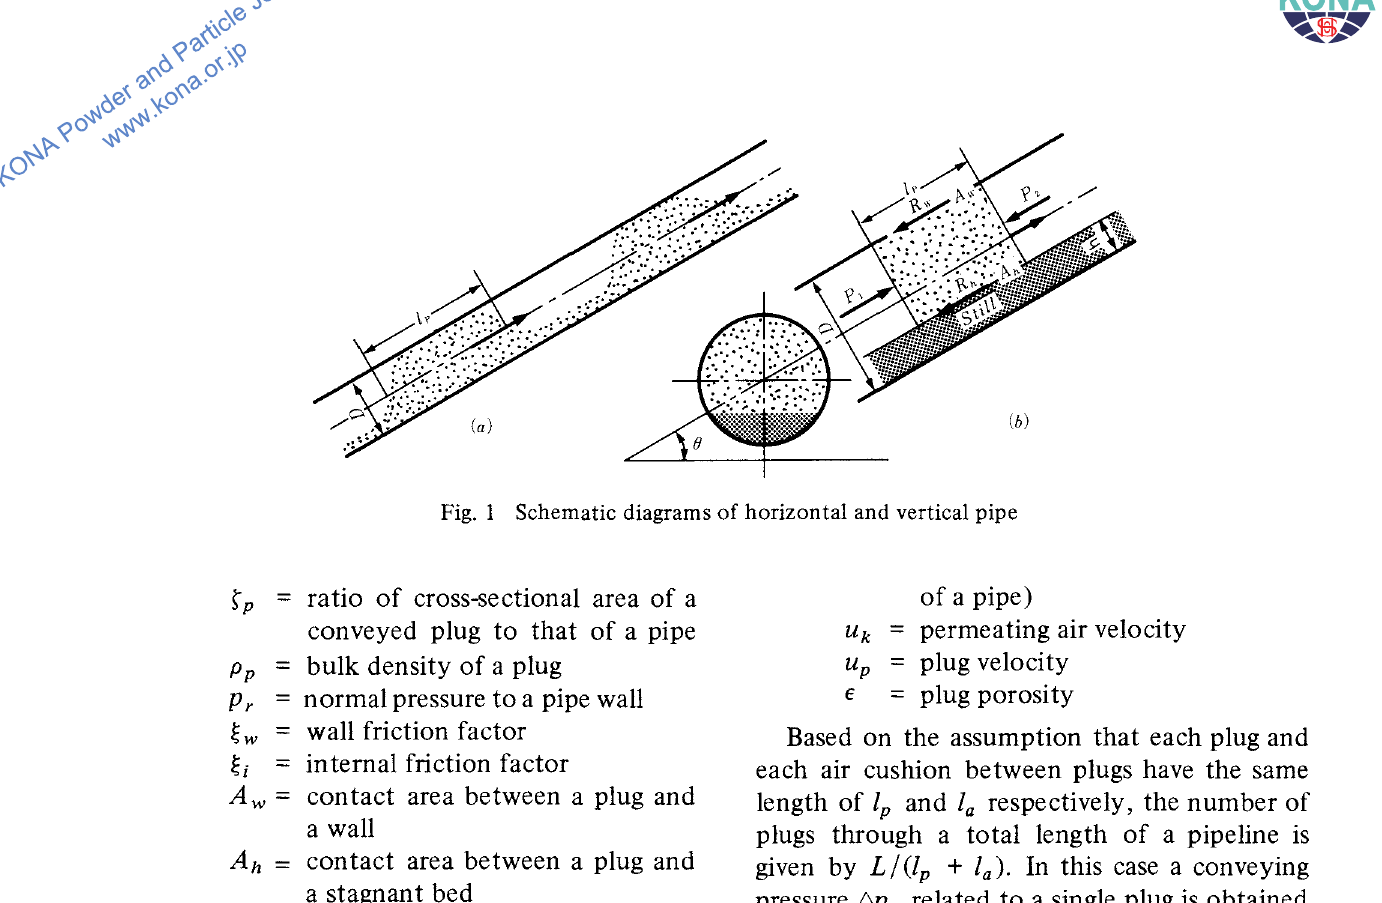
Fig. 1 Schematic diagrams of horizontal and vertical